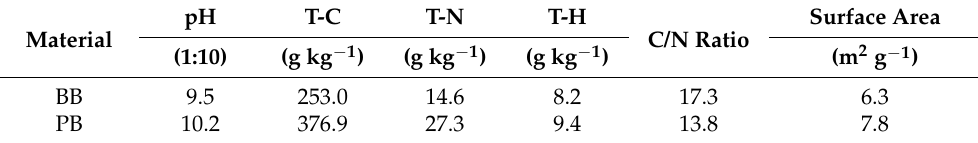
Table 2. Physicochemical properties of